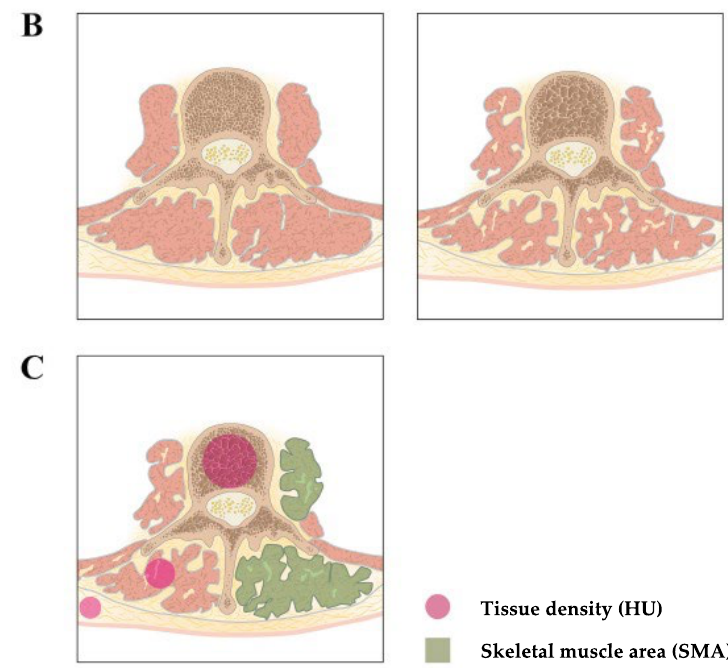
Figure 1. Plane imaging at the mid-pedicle level of L3 of patients with normal muscle mass (left) and sarcopenia (right). Computed tomography images( A ), outlines ( B ), and skeleton muscle area (SMA) and skeleton muscle density (SMD) (in Hounsfield unit (HU)) measurements ( C ).